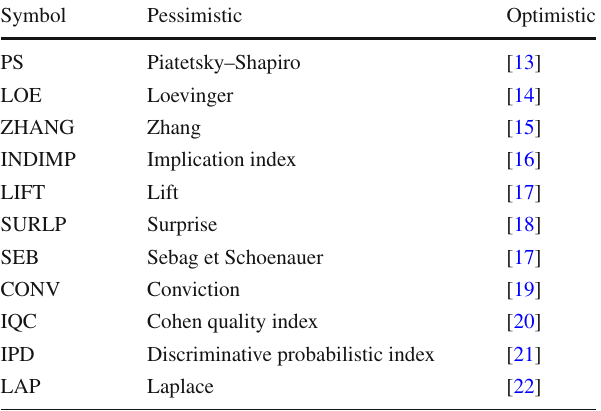
Table 1 The set of quality